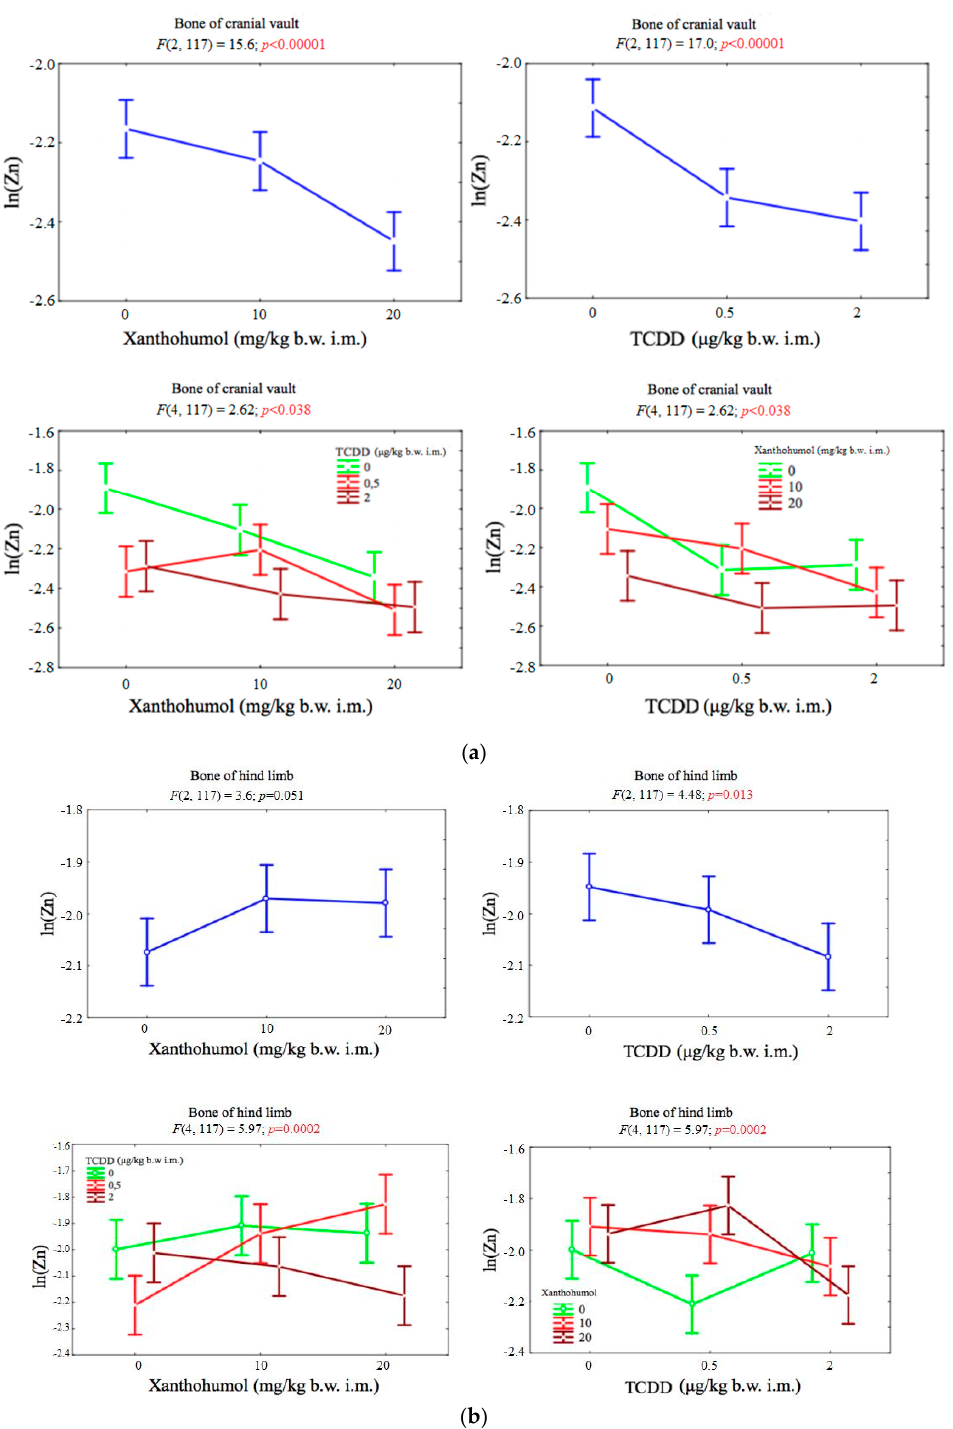
Figure 4. ( a ) Average zinc concentration (transformed variables) in the bone of the cranial vault, depending on the dose of TCDD and xanthohumol, and results of the significance test. Results are represented as mean ± SD. p ≤ 0.05 was considered statistically significant. Significant p value is highlighted in bold. ( b ) Average zinc concentration (transformed variables) in the bone of the hind limb, depending on the dose of TCDD and xanthohumol, and results of the significance test. Results are represented as mean ± SD. p ≤ 0.05 was considered statistically significant. Significant p value is highlighted in